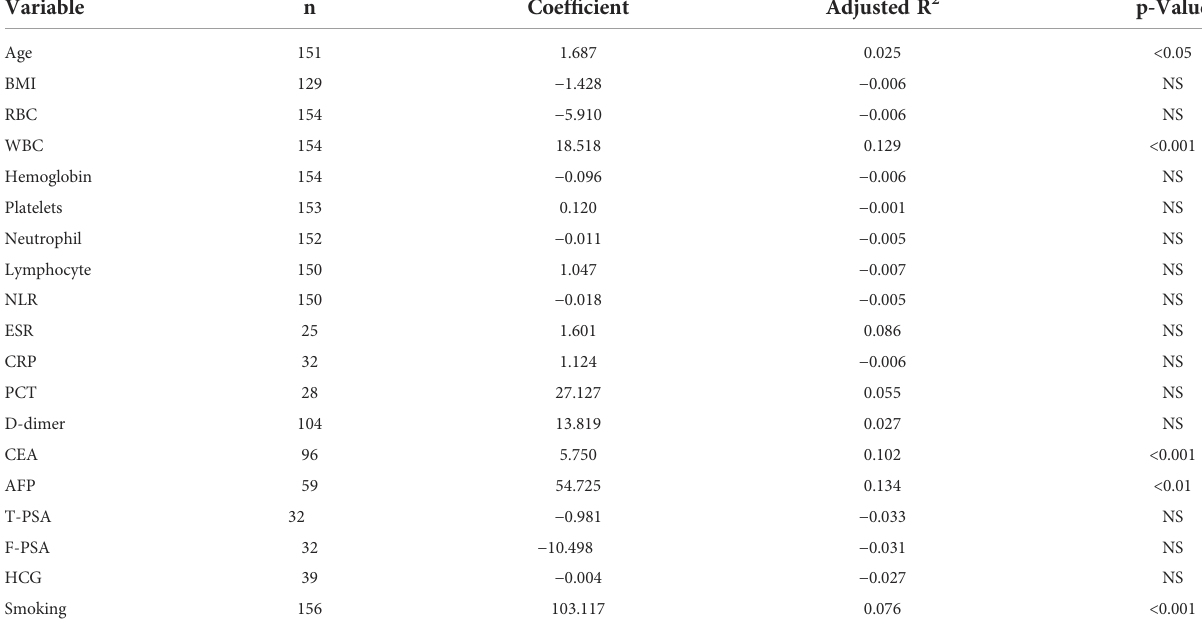
TABLE 3 Univariate analysis of correlation between clinical variables and LIT score.